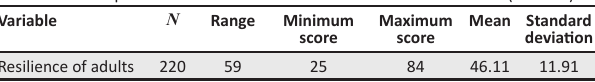
TABLE 1: Descriptive statistics of resilience of adults with blindness ( n = 220).